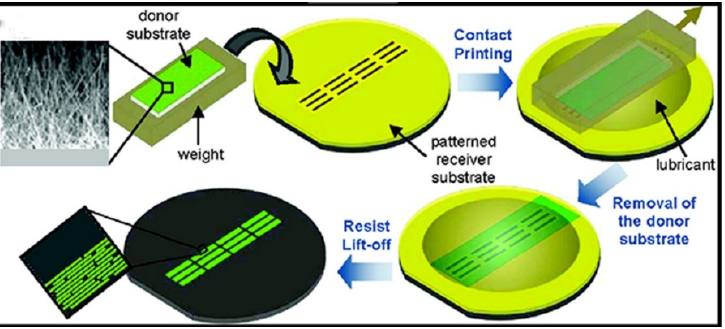
Figure 3. Schematic of the process flow for contact printing. Reprinted with permission from [70]. Copyright 2007 American Chemical Society.